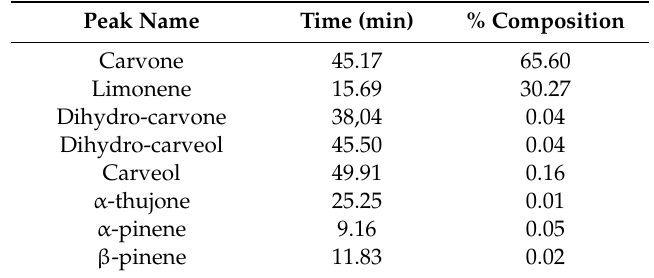
Table 2. Chemical composition of oil from Ko´nczewicki caraway fruit.